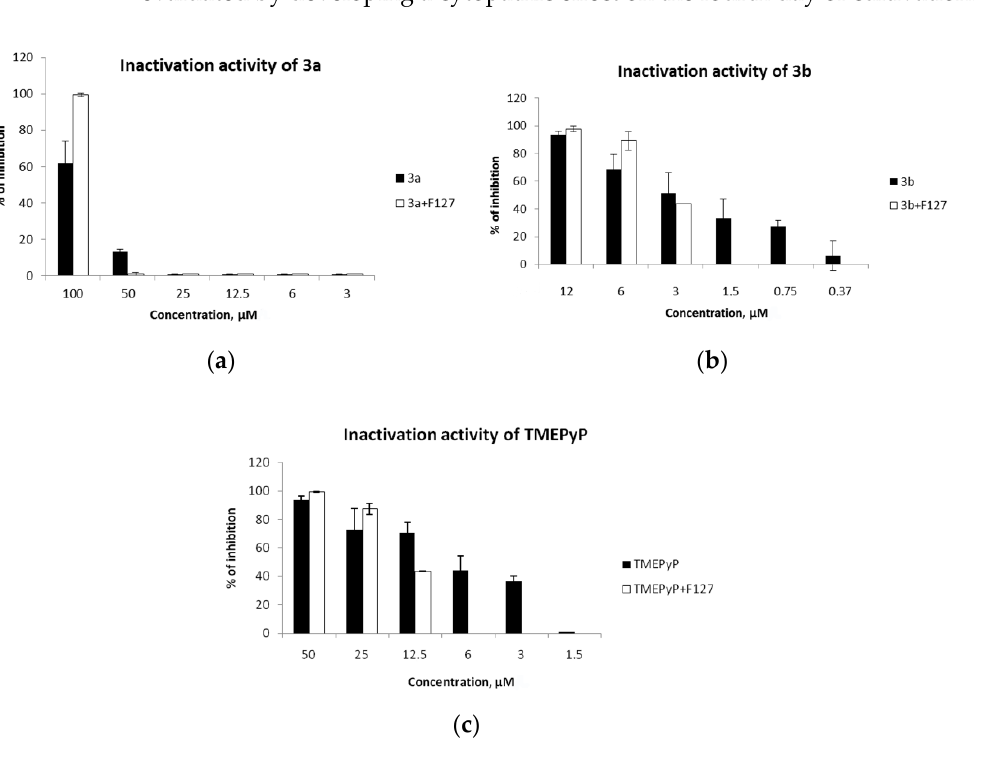
Figure 5. Virucidal activity of 3a ( a ), 3b ( b ), TMePyP ( c ) dissolved in PBS and Pluronic F-127 regarding HSV-1. The results are presented as the virus titer percentage, with the porphyrin regarding the virus titer in control, which was taken as 100%. Each point represents the mean ± deviation of three experiments with three replicates.